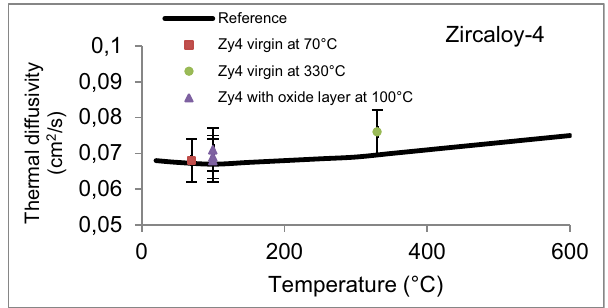
Fig. 8. Measured and reference values of thermal diffusivity as a function of temperature ( ° C) for Zy4